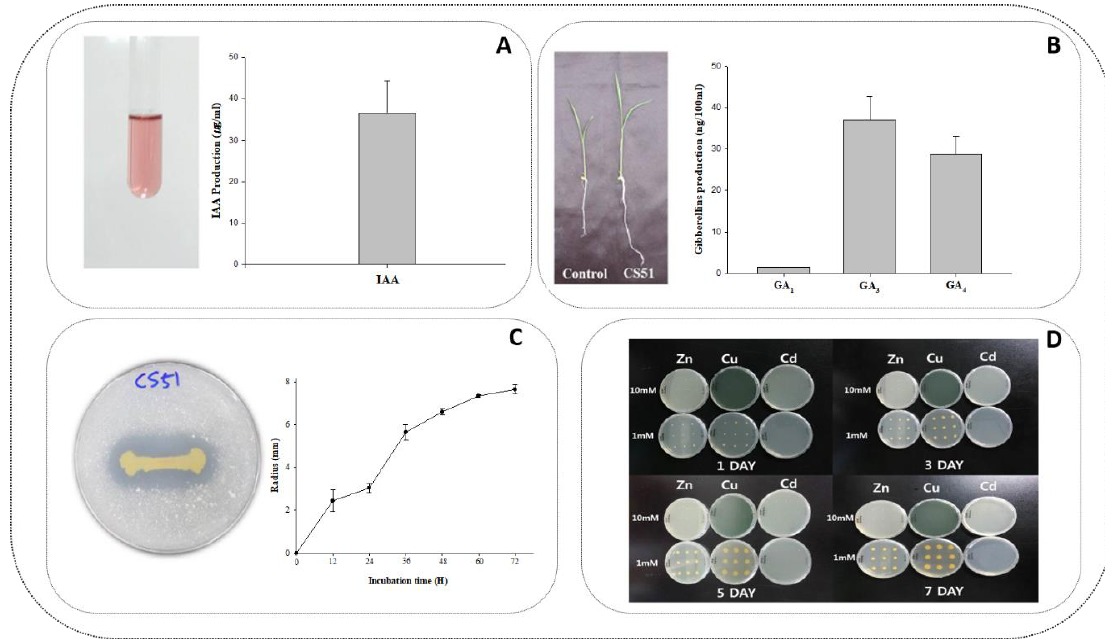
Figure 1. ( A ) Salkowski test for indole-3-acetic acid (IAA) determination and the amount of IAA produced by CS51 by GC-MS/SIM spectrometry analysis, ( B ) growth promoting effect of CS51 inoculation on Waito-C (gibberellins (GA) deficient) rice plants and the amount of different GAs produced by CS51 by GC-MS/SIM spectrometry analysis, ( C ) growth pattern of CS51 in 1 mM and 10 mM Zn-supplemented, Cu-supplemented, and Cd-supplemented media, ( D ) phosphate-solubilizing activity of CS51 on national botanical research institute’s phosphate (NBRIP) growth media plates, and incubated for 7 days at 30°C. The clarification halos show P solubilization and the maximum size of the clarification halos was reached after 72 values given are means of three replicates. Error bars indicate standard deviations.